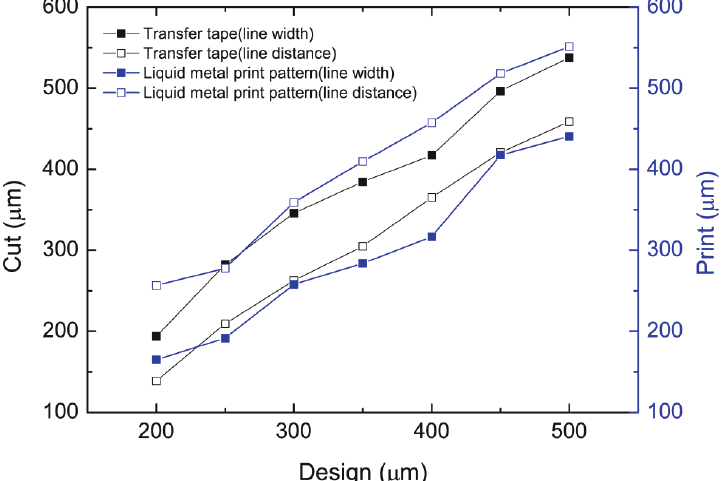
Figure 3. Comparisons of the line width and spacing of the mask design, the cut mask and the printed liquid alloy patterns.